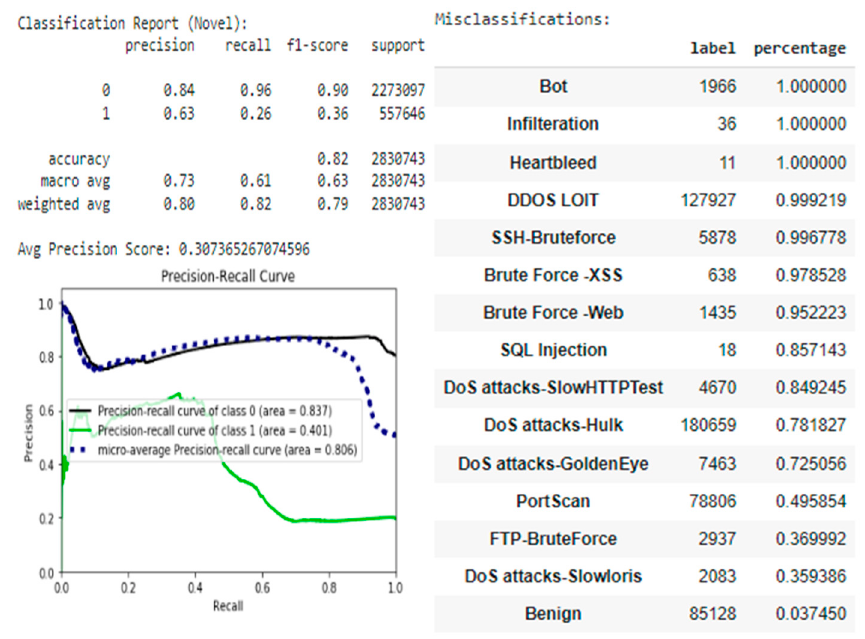
Figure 8. Testing on novel data.